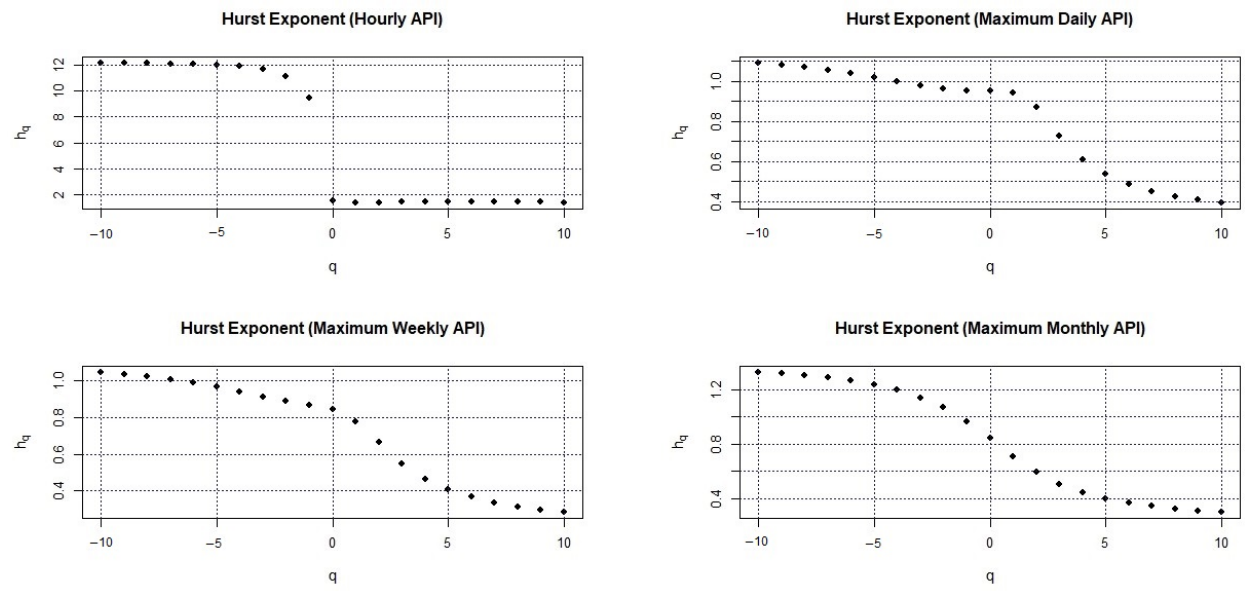
Figure 6. Plots of h(q ) versus q for hourly API series in Klang.